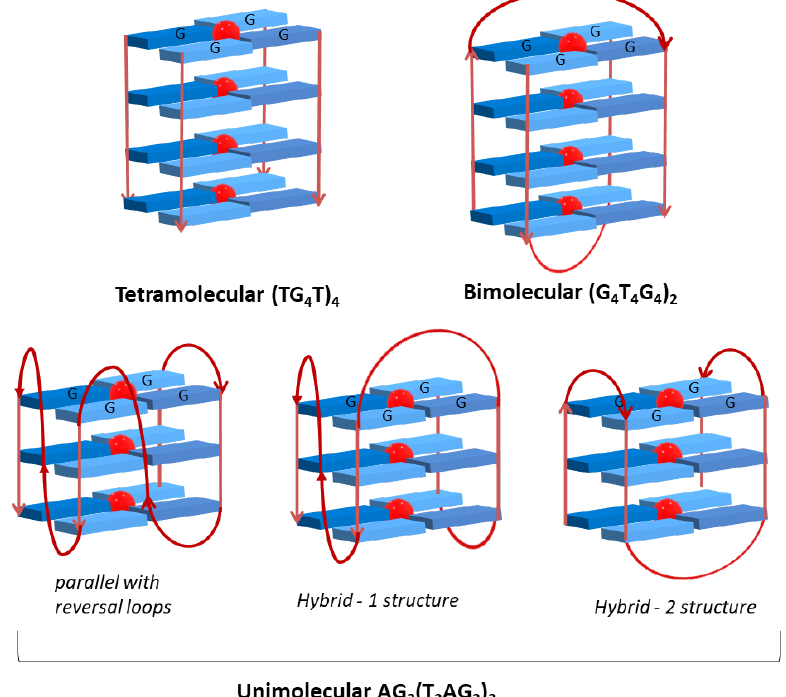
Figure 15. Structure and possible topology of the studied G-quadruplexes.